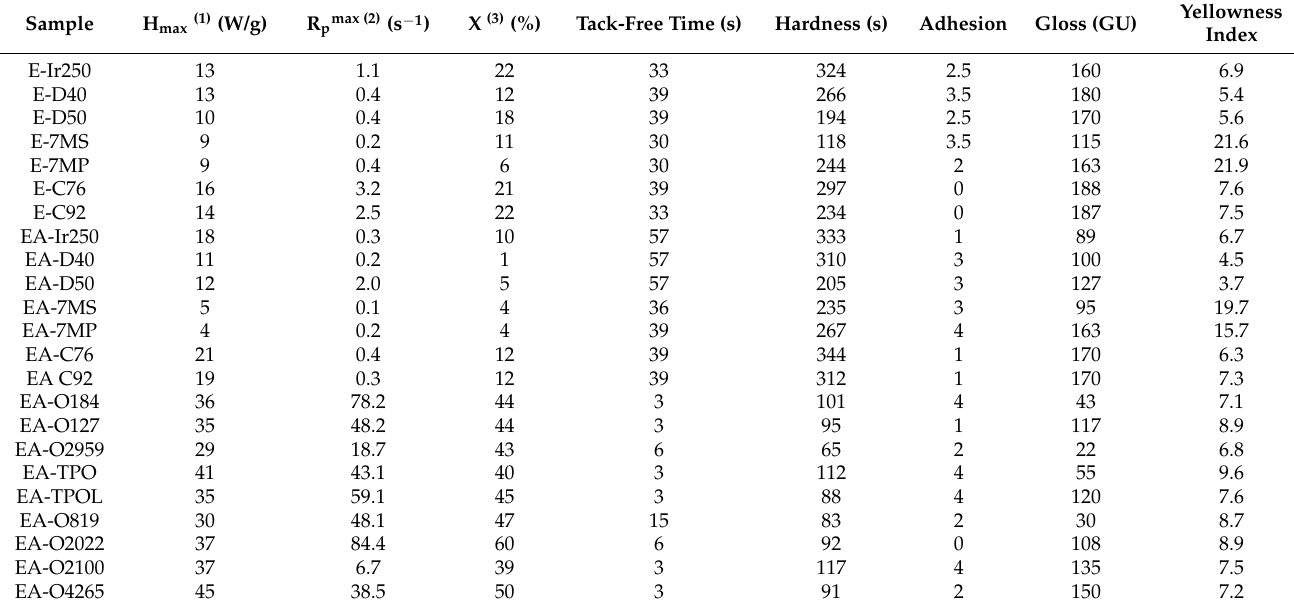
Table 2. Photopolymerization characteristics of the reaction mixtures and the basic properties of the cured coatings. Sample H max (1)